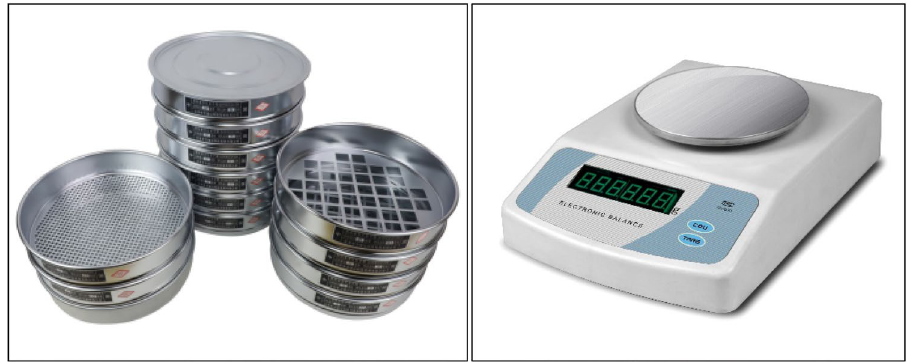
Figure 3. Square hole sieve and high-precision electronic balance.